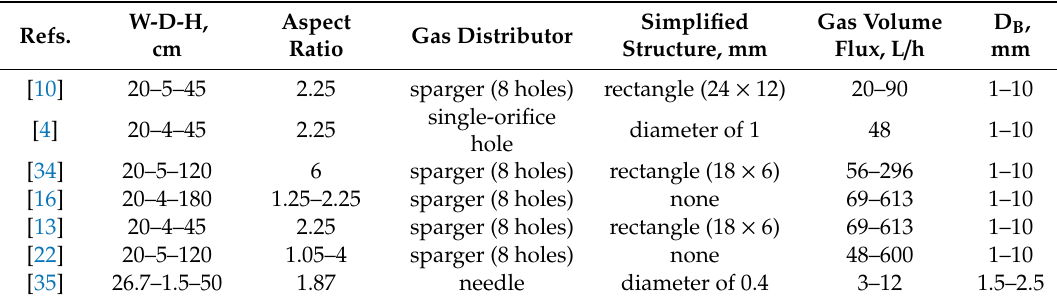
Table 1. Details of the experimental data in the